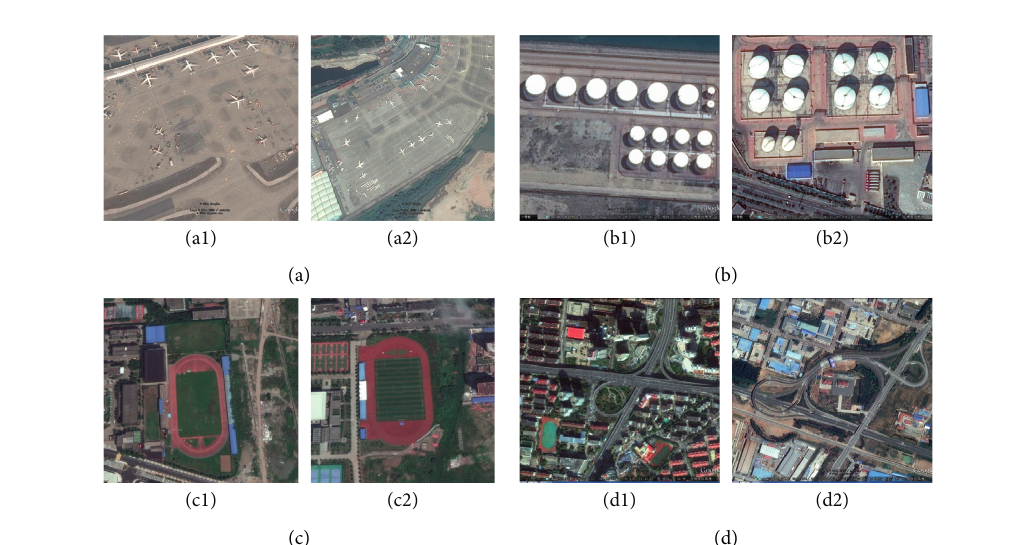
Figure 12: MSRDN-B network structure.